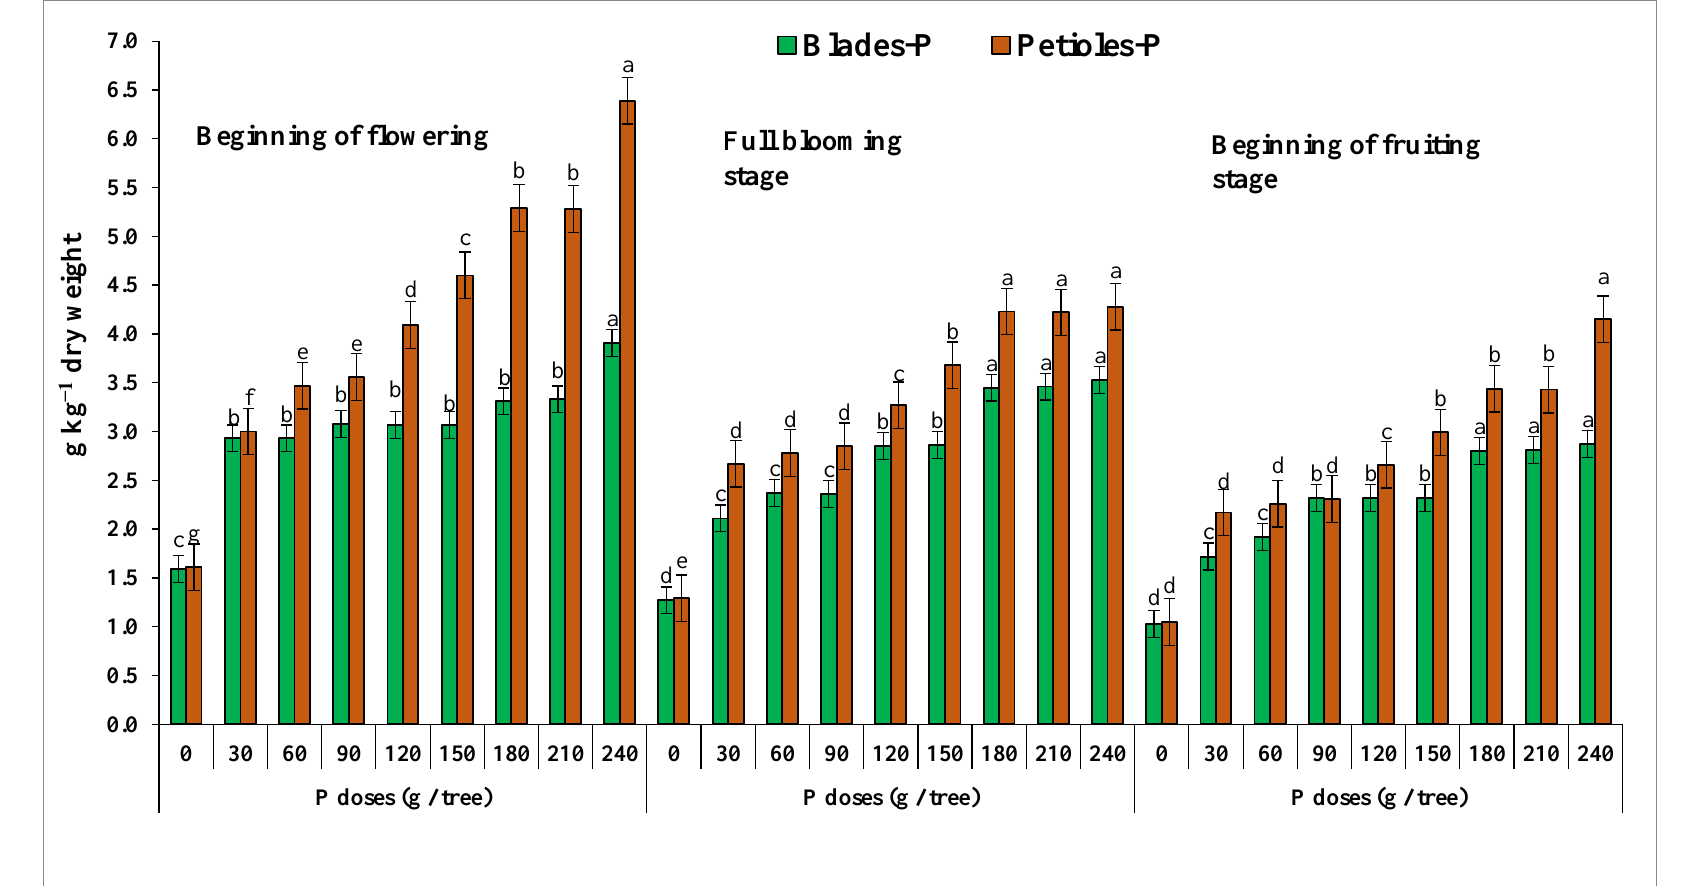
Figure 2. The effect of P doses on blade-P and petiole-P at different growth stages. Means ( ± SE, n = 16) denoted by different letters indicate significant difference according to Duncan’s test at p < 0.05.